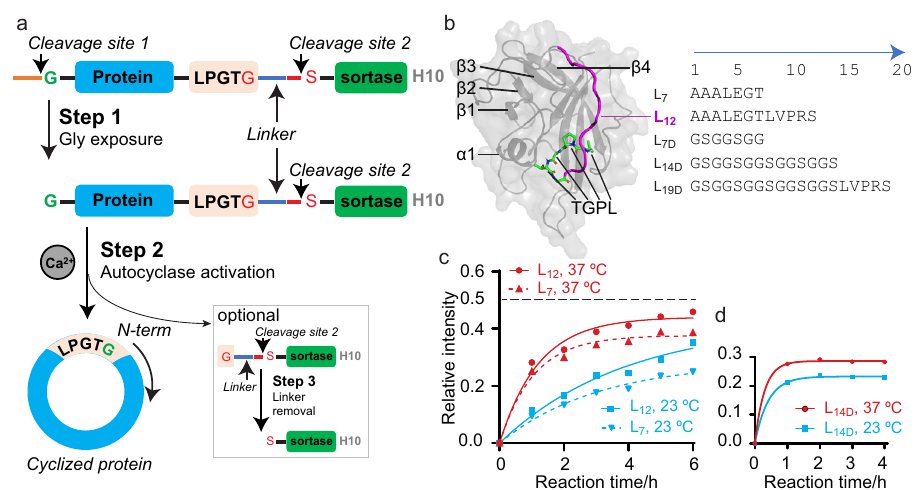
Fig. 1 Design of autocyclases as a modular, self-cyclising protein family. a An autocyclase construct features an N-terminal capping sequence (orange line), a protease cleavage site 1 (TEV site — ENLYFQ/G), protein of interest to be cyclised (blue rectangle), SrtA recognition site (pink rectangle), linker (blue line), protease cleavage site 2 (red line, thrombin site — LVPR/S), SrtA (green rectangle) and a C-terminal puri fi cation tag (His 10 — H10 — in grey). The cyclisation process involves TEV cleavage at cleavage site 1 to expose the N-terminal glycine (step 1), activation of cyclisation reaction using Ca 2 + ions (step 2) and optionally thrombin cleavage at cleavage site 2 to remove the linker and recover nucleophile free SrtA (step 3). b Five linkers (L 7 , L 12 , L 7D , L 14D and L 19D ) were designed to connect the protein of interest to the SrtA. MD simulations illustrated that the L 7 and L 12 linkers (L 12 shown in magenta) allows the SrtA recognition site (LPGT residues highlighted in green sticks) to be appropriately positioned at the active site of SrtA. c , d Quantitation of SDS-PAGE images (Supplementary Fig. S1) showing the buildup of cMSP9 from autocyclases (aMSP9) over 0 – 6 h. c The cyclisation rate of cMSP9 was faster for the aMSP9-L 12 than aMSP9-L 7 regardless of temperature (23 °C in cyan and 37 °C in red). The theoretical and maximum relative intensity of the cyclic product is ~0.5 (excluding SrtA), indicated by a dash line. The reactions were faster at 37 °C for both constructs. d A remarkable increase of reaction rate is observed for the autocyclase containing a dynamic L 14D